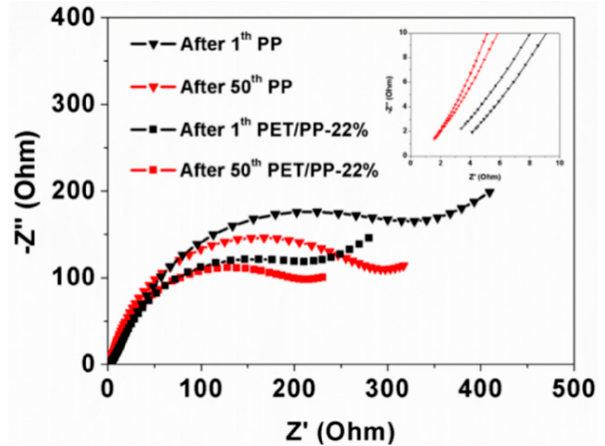
Figure 12. The variation in AC impedance spectra (1st cycle-50th) of cells assembled with PP separator and PET/PP-22%.